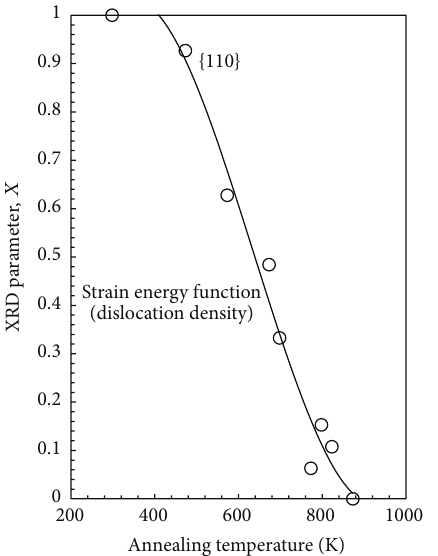
Figure9:X-rayparameterasafunctionofthepost-ECAPannealing temperature.